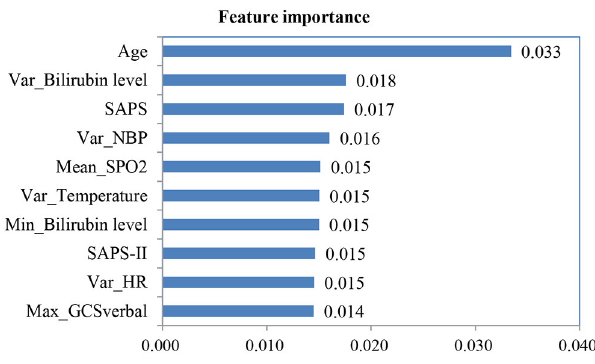
FIGURE 12 | Ten most important features using the random forest method.